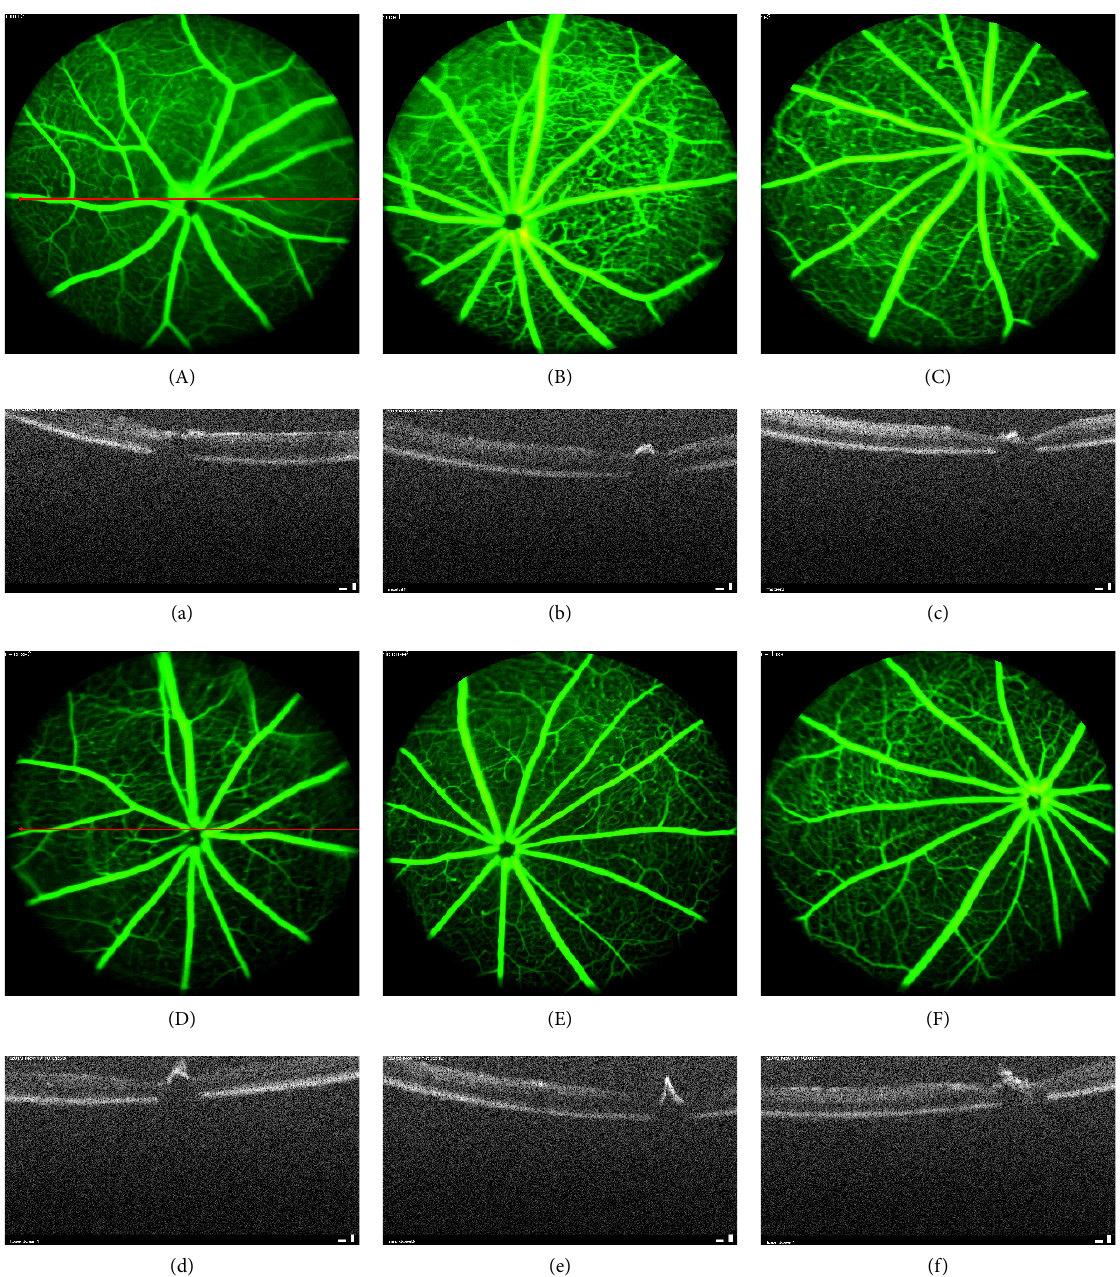
Figure 9: Retinal imaging by OCT and FA in db/db diabetic mice. (A)–(F) Results of examination of the fundus by fluorescein angiography (FA), (a)–(f) Results of retinal imaging by optical coherence tomography (OCT). The OCT result shows the optic nerve fiber layer of db/db micethinned(b),comparedwiththenondiabeticgroup(a).ThethinningofopticnervefiberlayerwasmildlyreversedbytheTNTLtreatment ((d), (e), and (f) at the dose of 3.6 g, 1.8 and 0.9 g/kg b.w., resp.). There is no alleviation in the Met treatment mice (c) for the optic nerve fiber layer thickness. FA shows that there are numerous vascular calibers (pathological neovascularization) in the db/db mice fundus (B). The TNTL treatment ((D), (E), and (F) at the dose of 3.6 g, 1.8 and 0.9 g/kg b.w., resp.) can significantly reduce the density of vascular calibers in fundus oculi; nevertheless, the positive group (C) shows no significant